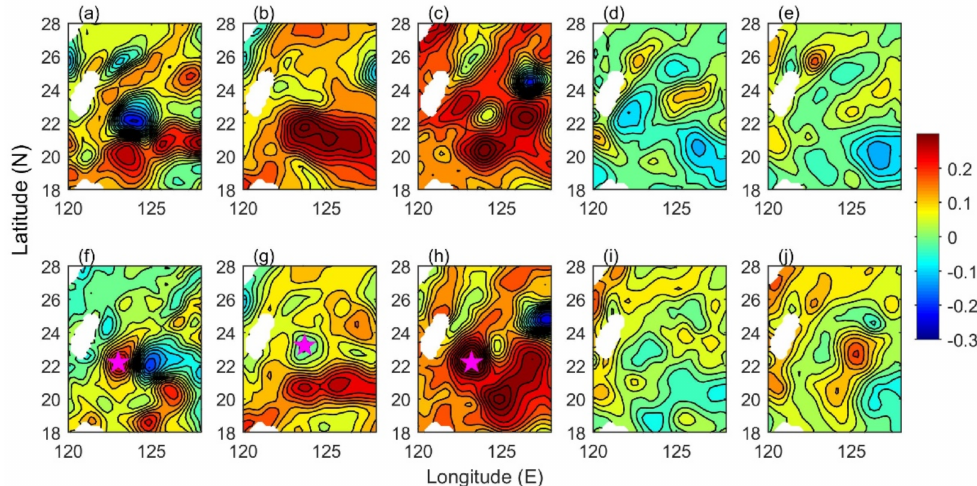
Figure 13. Mean sea level anomalies (unit: m) during the P1 ( a ), P2 ( b ), P3 ( c ), P4+ ( d ) and P4 − ( e ) periods. Mean sea level anomalies 30 days before the P1 ( f ), P2 ( g ), P3 ( h ), P4+ ( i ) and P4 − ( j ) periods. The contour interval is 0.03 m. The pentagram marks the location of the mesoscale